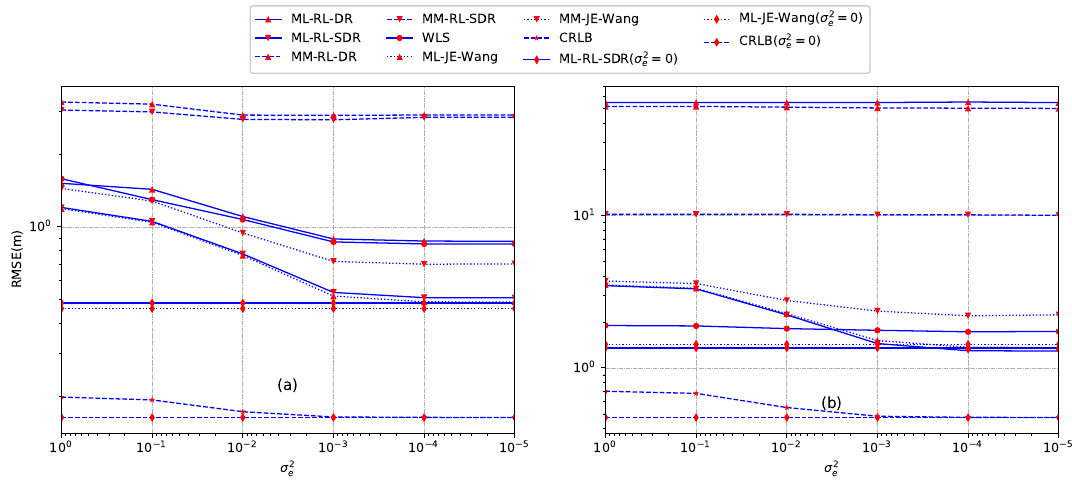
Figure 10. Comparison of source localization methods against energy decay factor error. ( a ) the source is located at y = [ 20,30 ] T ; ( b ) the source is located at y = [ 80,20 ] T